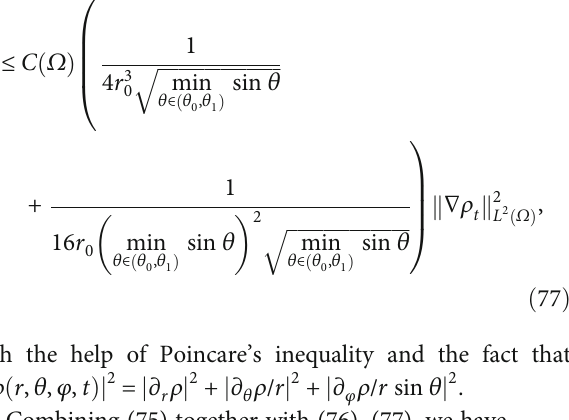
ffiffiffiffiffiffiffiffiffiffiffiffiffiffiffiffiffiffiffiffiffiffiffiffi min